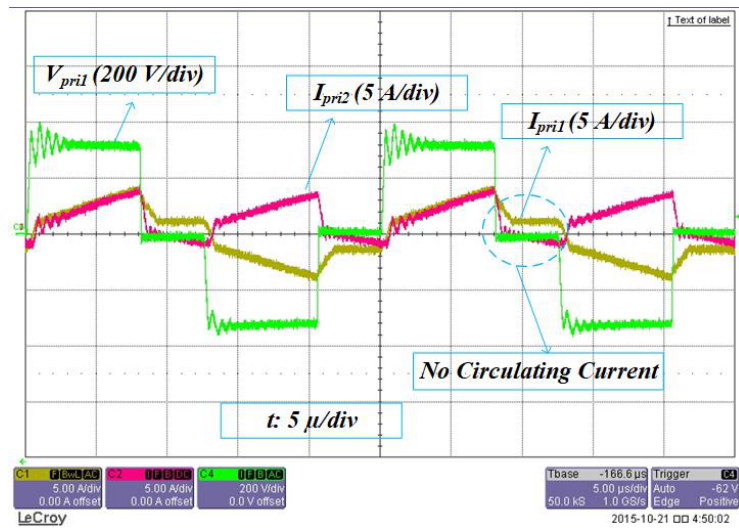
Figure 13. Voltage and current of transformer 𝑇𝑅 1 at 100% of load.